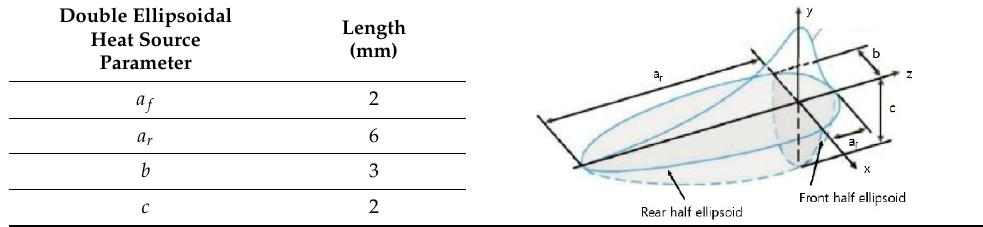
Table 2. The double ellipsoidal heat source parameters.